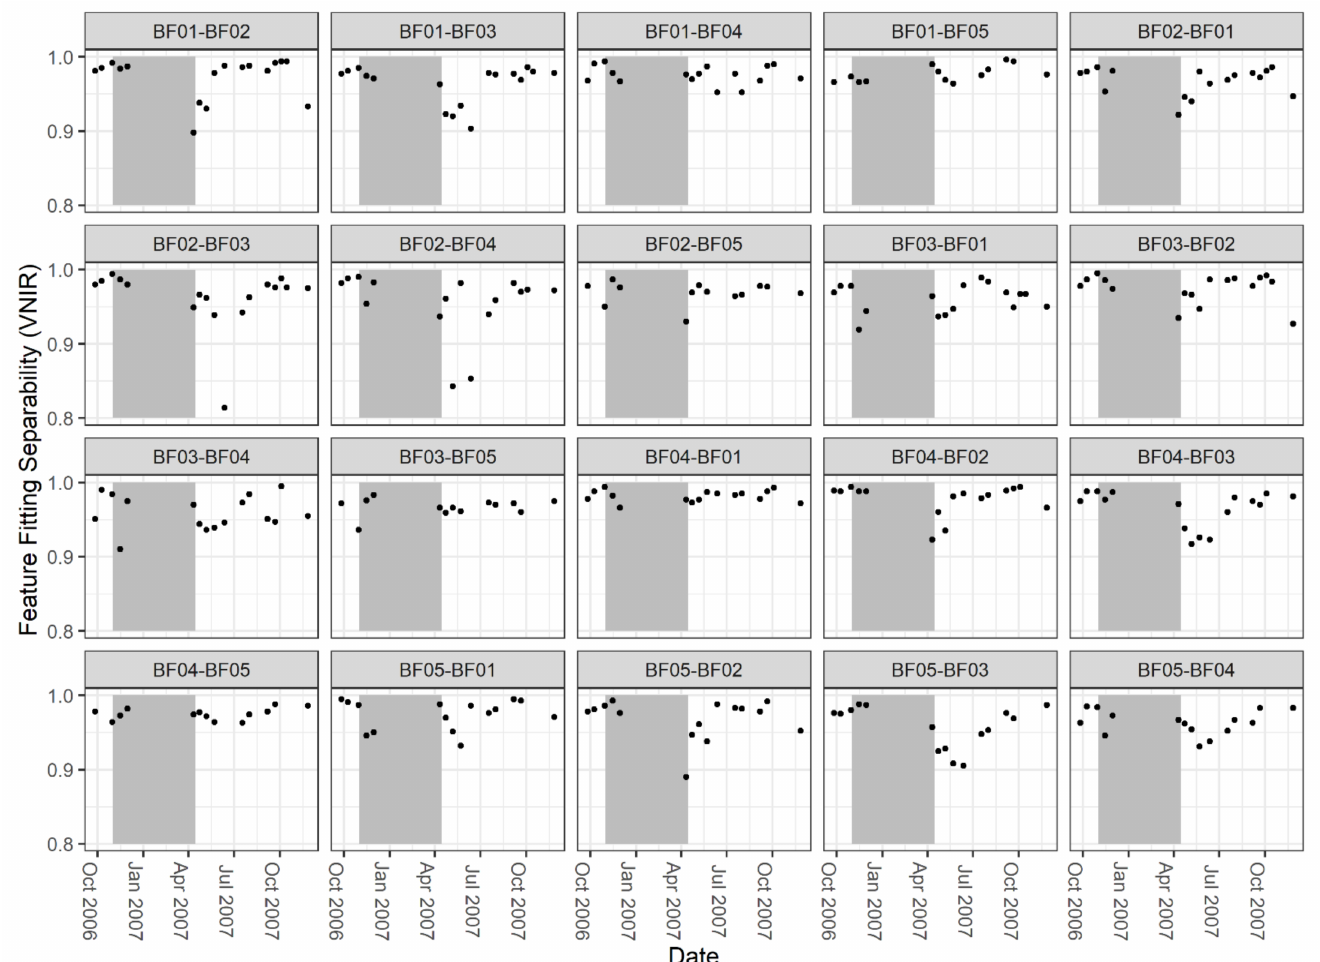
Figure 9. Feature Fitting (VNIR). The grey area is the wet season (1 November 2006 and 1 April 2007). No data is plotted from BF01 and BF02 from June 2007, due to disturbance of ground cover. BF01 D. milanjiana (Jarra grass), BF02 and BF03: B. humidicola (Tully grass), BF04: D. milanjiana (Arnhem grass), and BF05: D. eriantha (Pangola